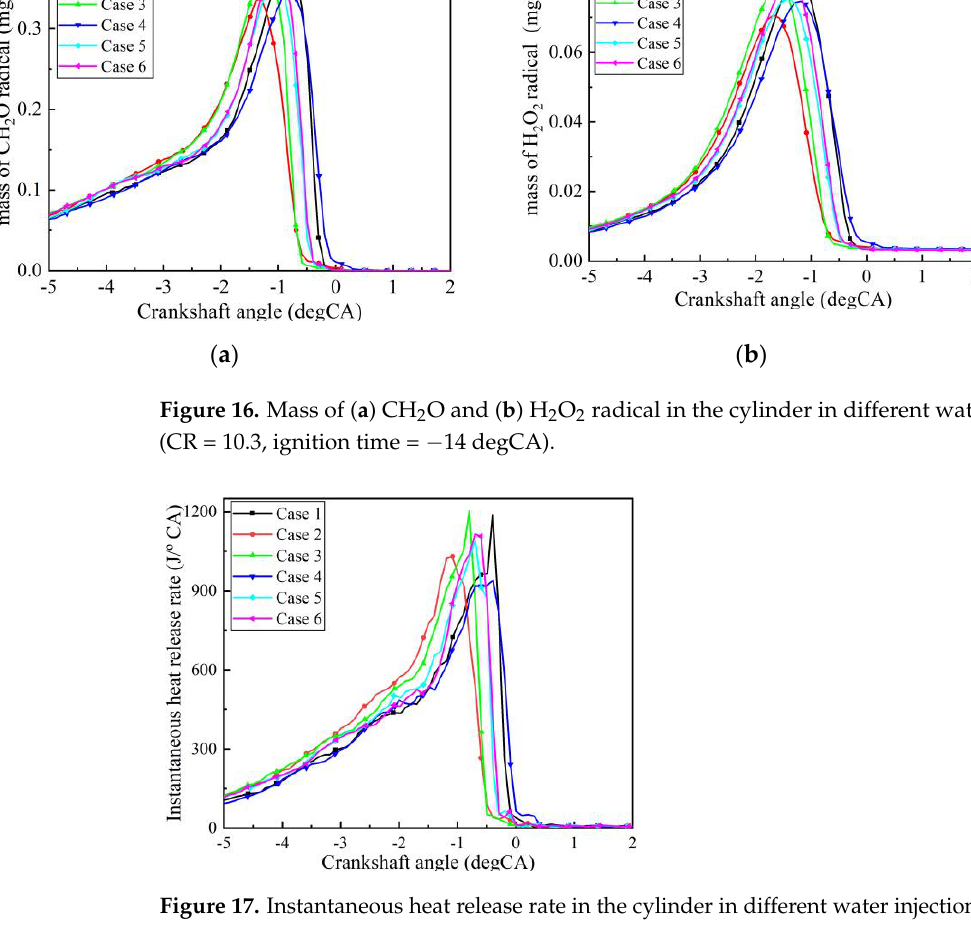
Figure 17. Instantaneous heat release rate in the cylinder in different water injection cases (CR = 10.3, ignition time = − 14 degCA).